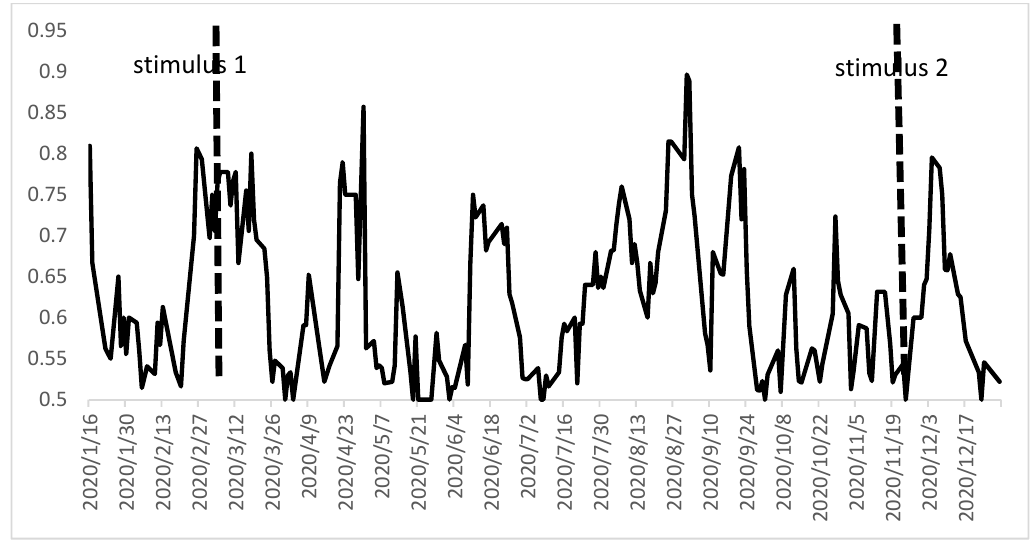
Figure 3. Aggregate KU event ECI. Notes: The figure plots the expectations concordance index (ECI) for an aggregate of KU events as reported in the Bloomberg News stock market wraps for 2020. The left vertical dashed line corresponds to the passage of the $2T Congressional stimulus package on 26 March 2020. The right dashed line corresponds to the second stimulus package signed into law on 27 December 2020.